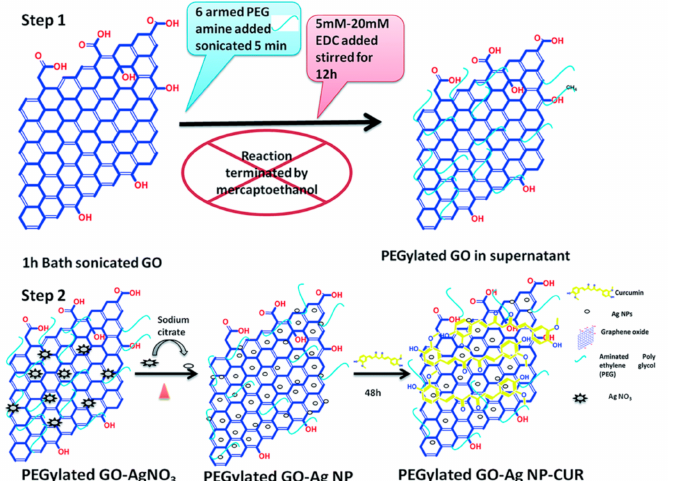
Figure 6. Schematic of synthesis of PEGylated GO and PEGylated-GO-based nanocomposites